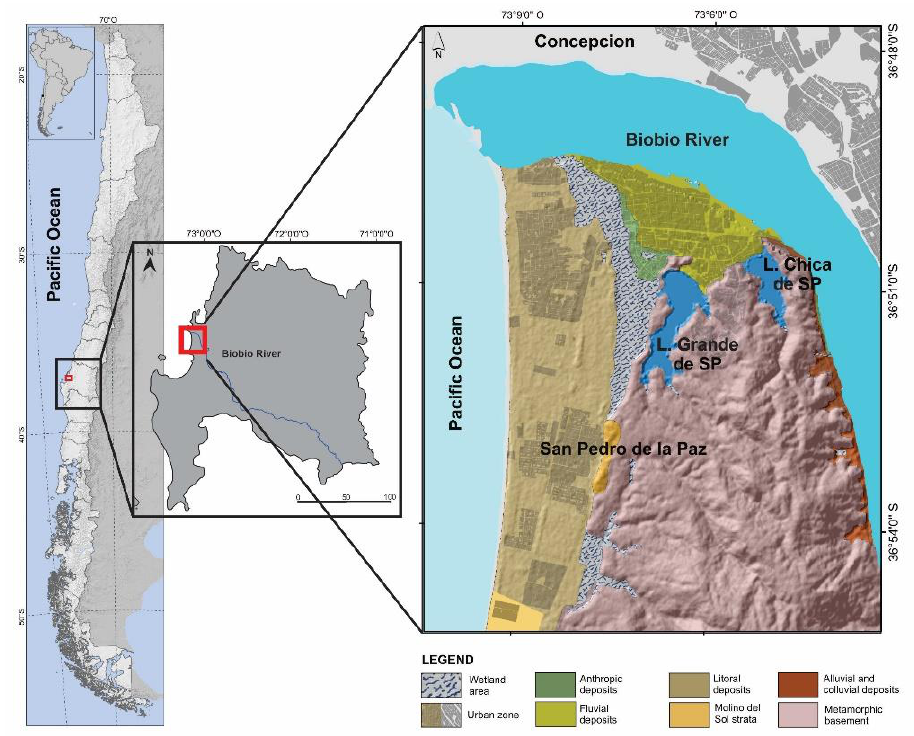
Figure 1. Study area of the Laguna Grande and Laguna Chica de San Pedro. Table 1. Summary of environmental, physico-chemical and biological characteristics of the Laguna